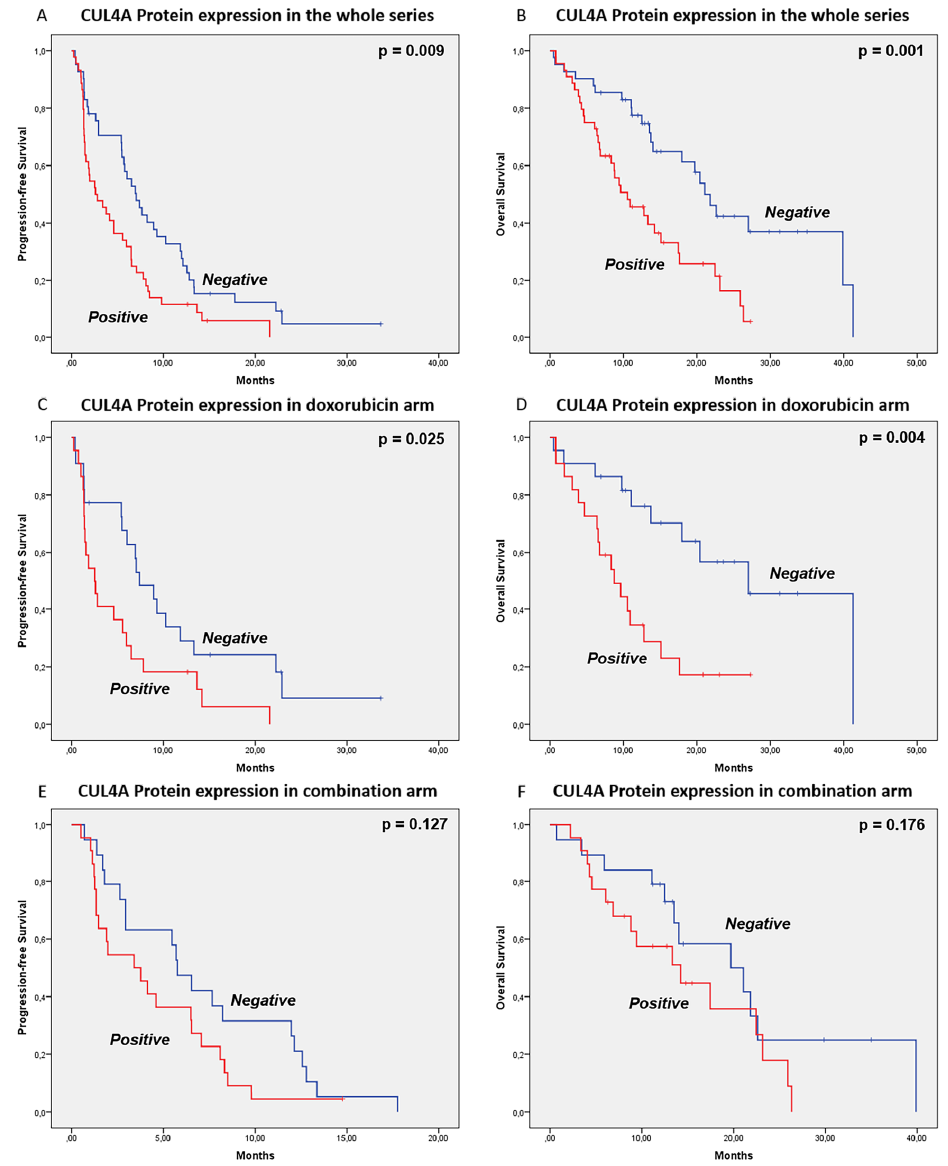
Figure 2. Prognostic and predictive value of CUL4A protein expression. Samples were grouped as CUL4A positive or negative, taking into account the nuclear expression levels evaluated by immunohistochemistry. Antibody: anti-CUL4A polyclonal antibody (1:50, 2699s, Cell Signaling Technology, Danvers, MA, USA). In the whole series CUL4A protein expression was associated with worse PFS ( A ): 2.60 months (95% CI: 0.58–4.62) vs 7.03 months (95% CI: 5.03–9.04), p = 0.009; and ( B ) and with worse OS ( B ): 10.57 months (95% CI: 5.95–15.18) vs 21.07 months (95% CI: 17.70–24.43), p = 0.001. In the doxorubicin arm, CUL4A expression was also associated with worse PFS ( C ): 2.53 months (95% CI: 1.12–4.00) vs 7.4 months (95% CI: 4.45–10.35), p = 0.025 and worse OS ( D ): 8.73 months (95% CI: 4.62–12.84) vs 27.03 months (95% CI: 16.99–37.08), p = 0.004. In the combination series, CUL4A protein expression did not correlate with PFS ( E ): 3.40 months (95% CI: 0.83–6.00) vs 5.77 months (95% CI: 4.25–7.28), p = 0.127, nor OS ( F ): 14.23 months (95% CI: 5.68–22.79) 19.70 months (95% CI: 8.82–30.58), p =